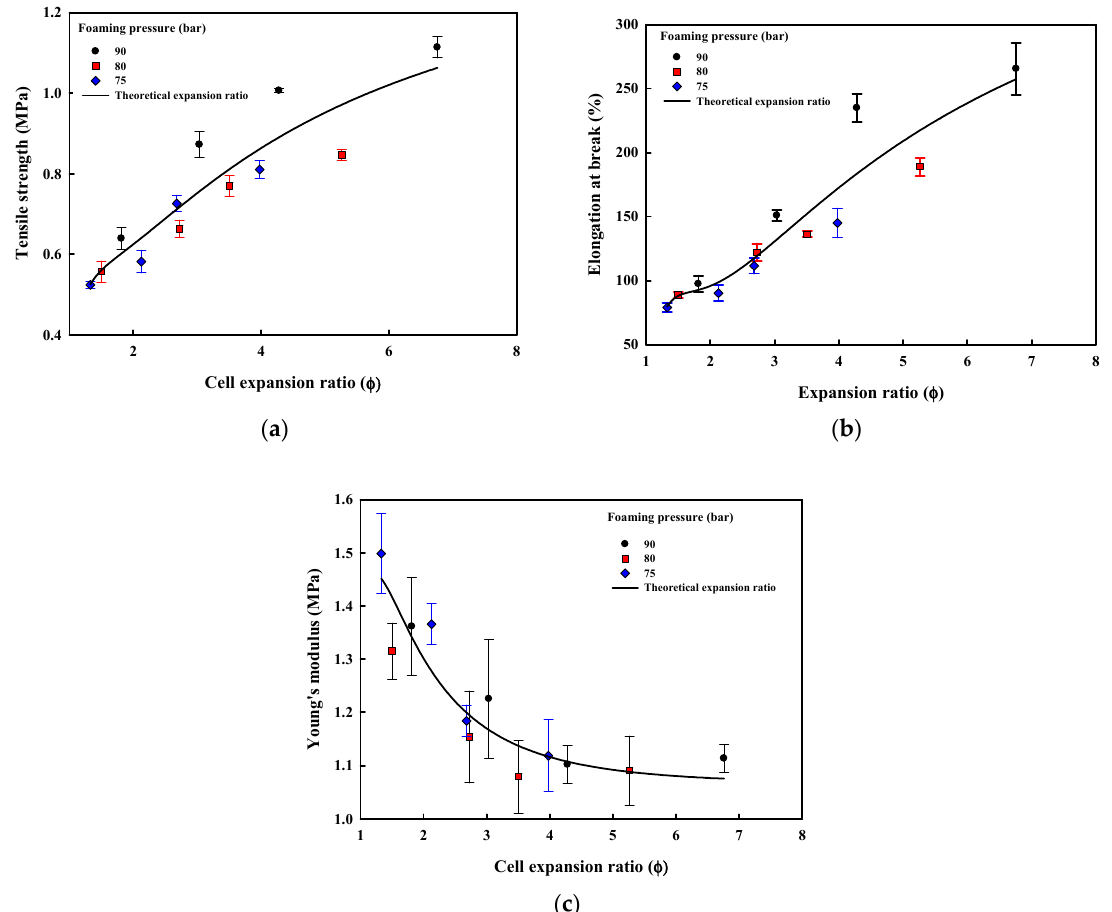
Figure 11. Mechanical properties of ETPU foam sheets: ( a ) tensile strength; ( b ) elongation at break; ( c ) Young’s modulus.